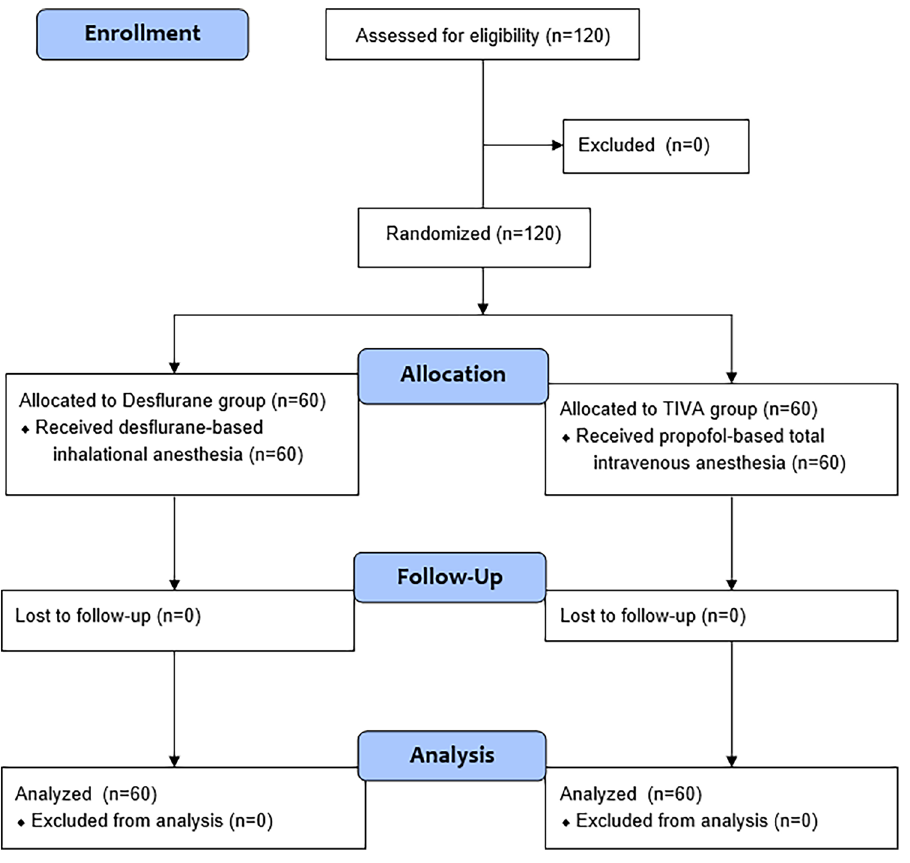
Figure 1. CONSORT flowchart, capturing the study